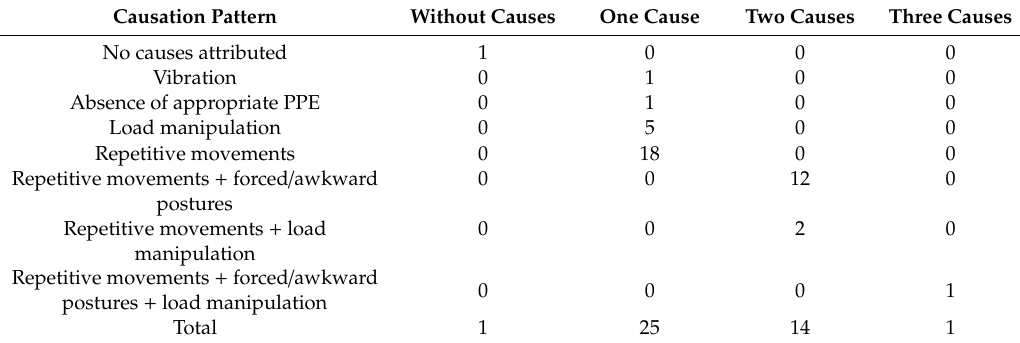
Table 9. Causation pattern attributed in the investigation